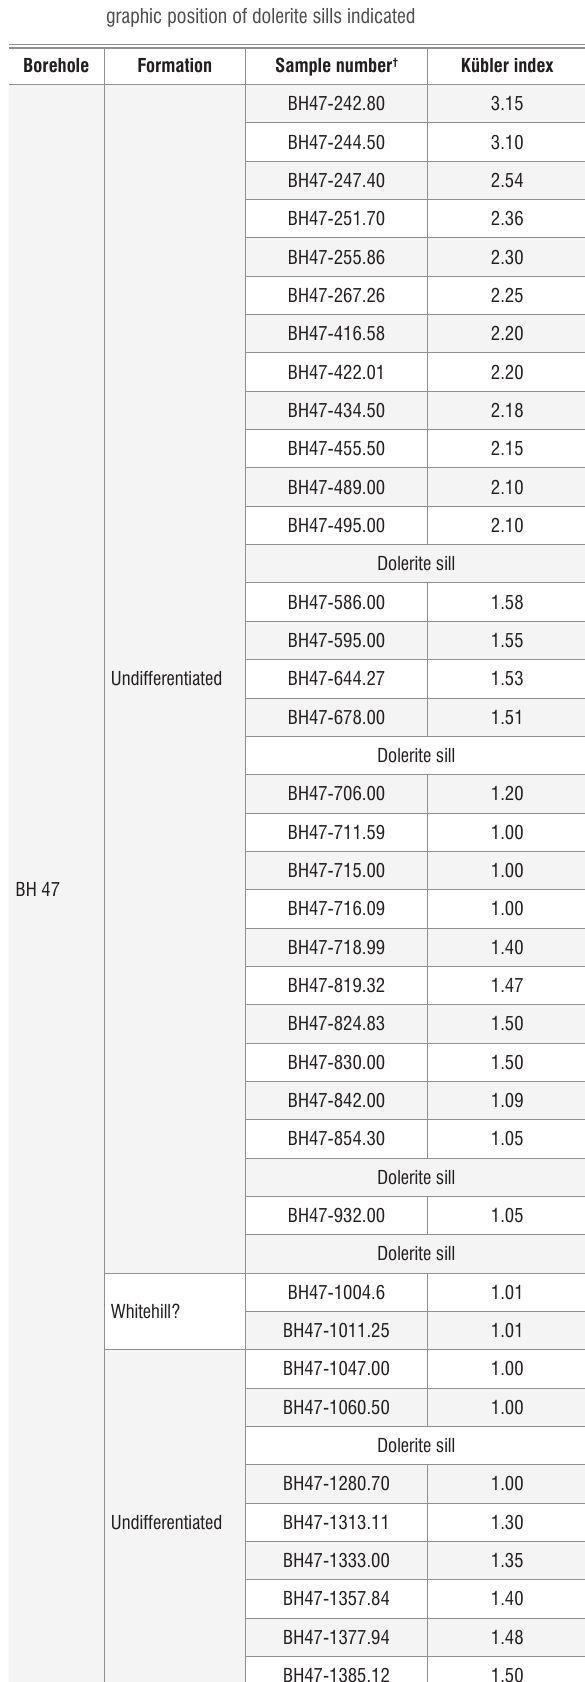
Kübler index of shale samples from BH 47 with relative